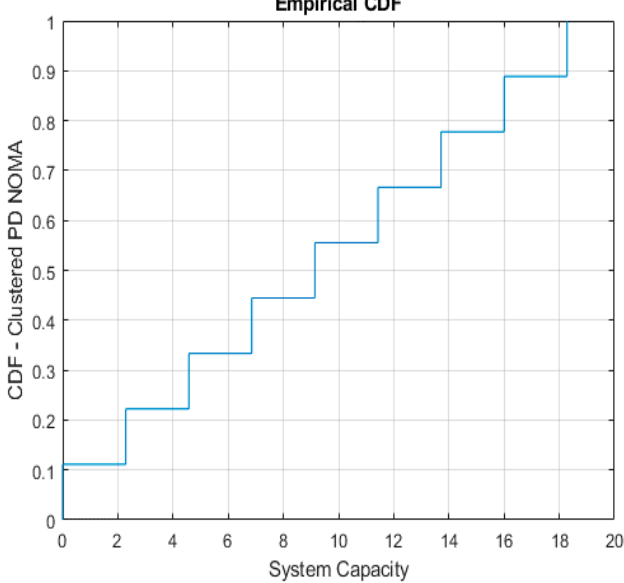
Figure 11. CDF of system capacity achieved with clustered PD-NOMA .